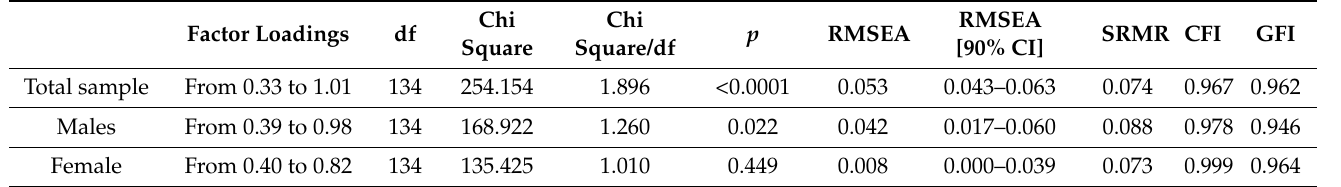
Table 3. Results of the application of CFAs in the study 2.